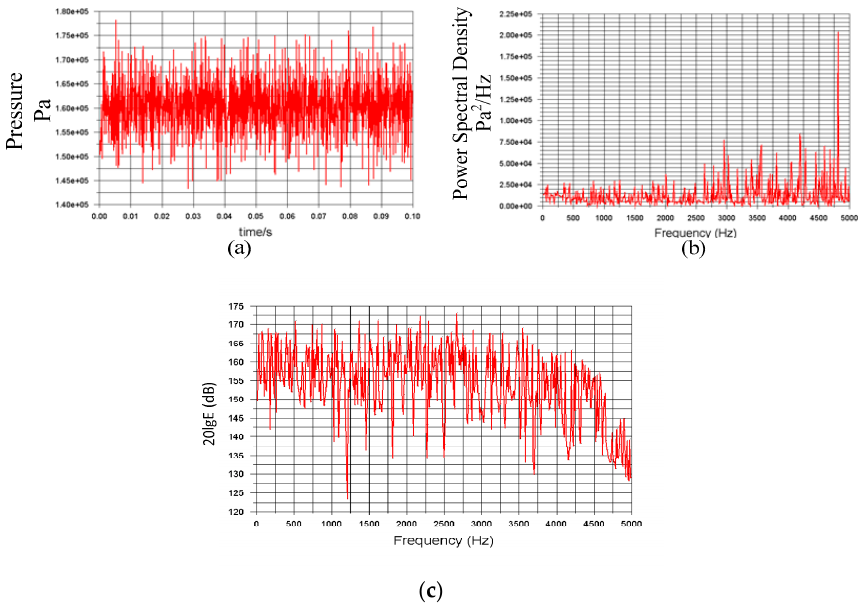
Figure 7. Pressure curves in time and frequency domains when the inlet velocity is 5 m / s. ( a ) Time domain. ( b ) Frequency domain. ( c ) 20logE frequency